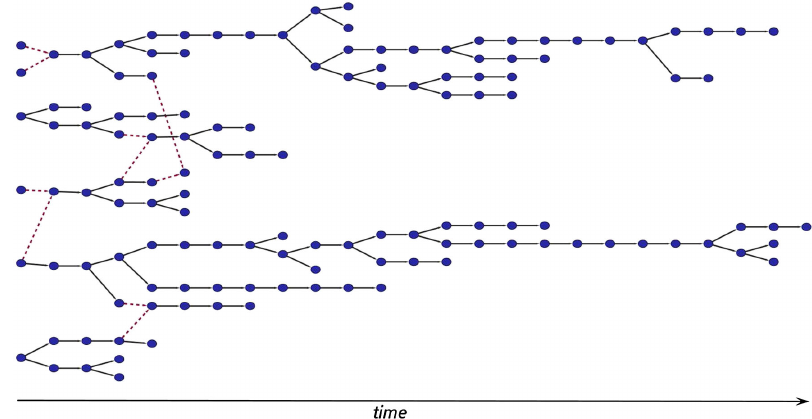
FIG. 6. Example of the pruning process from time t ¼ 10 till 34 in a small part of the Erd ő s-Rényi network with 10 5 nodes. Time progresses from left to right in the tree. Blue circles represent vertices removed at a given time step. Their removal results in the removal of vertices on the right, and so on. Crossings (dashed lines) between the branching processes are abundant at the beginning of the pruning process. They appear rarely after a short initial period. Typical trees of medium size are shown. Much longer and much shorter trees also